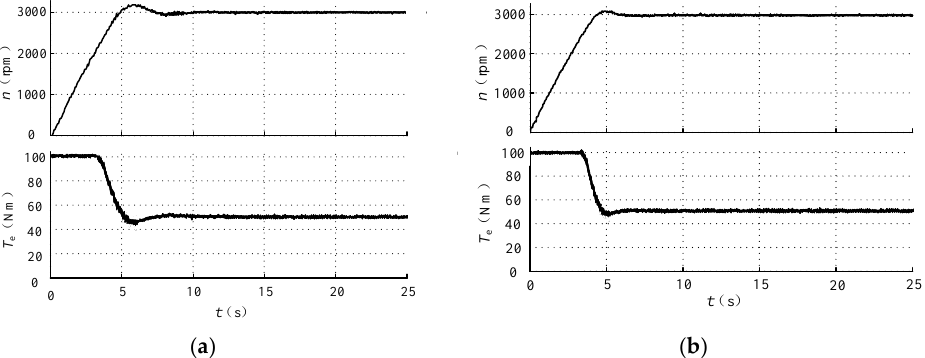
Figure 11. ( a ) Experimental waveform of the speed limit of the PI controller-based drive control system; ( b ) Experimental waveform of the speed limit of the sliding mode controller-based drive control system.